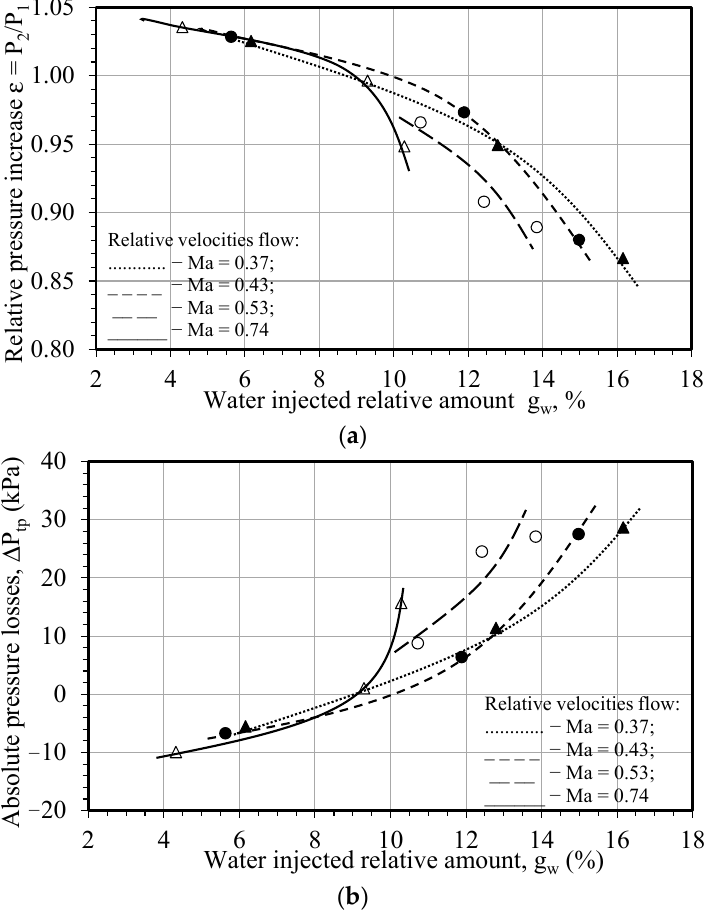
Figure 9. Experimental dependencies of the increase pressure ε tp = P 2 /P 1 ( a ) and the pressure loss in the thermopressor P tp = P 1 − P 2 on the water injected relative amount into the thermopressor flow part g w ( b ): ▲ – Ma = 0.37; ● – Ma = 0.43; ○ – Ma = 0.53; Δ – Ma = 0.74. The Student’s distribution method was used to determine relative pressure measure- ment errors. In this case, the error deviations δ tp ranged from ±1.81% to ±4.00%. The obtained measurement accuracy determines the reliability of the obtained experimental data.